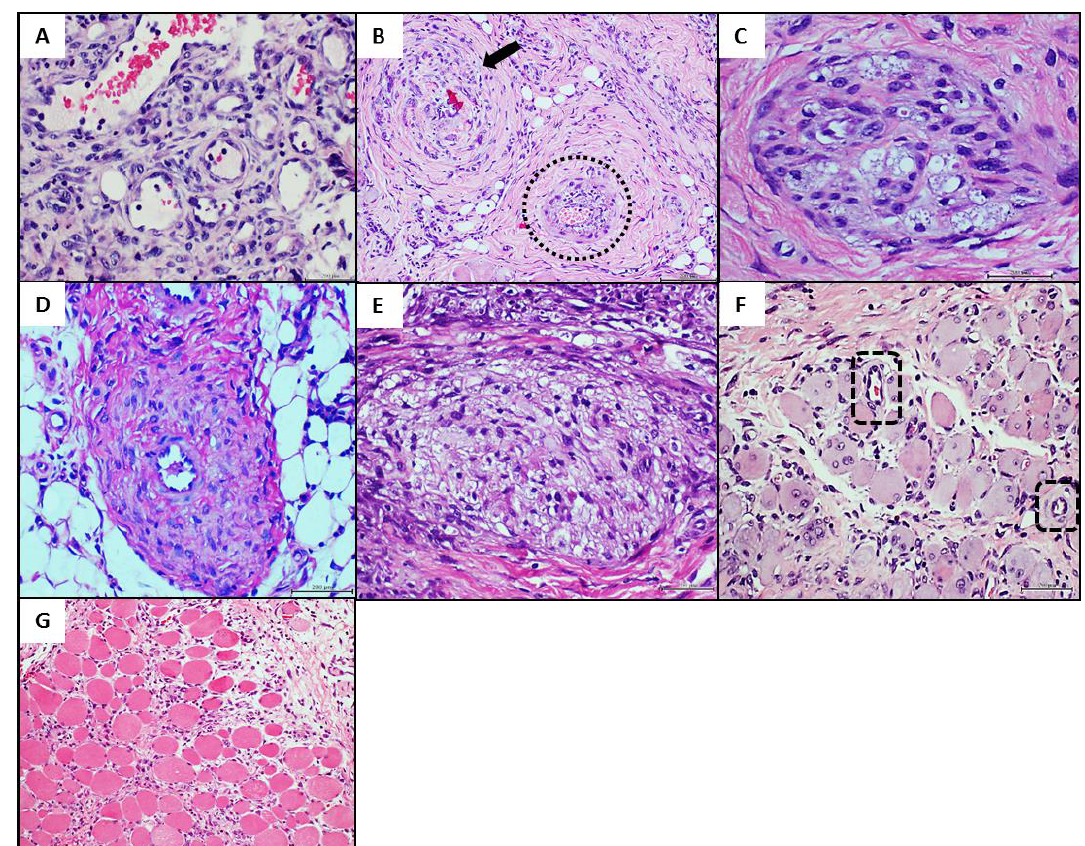
Figure 2. Histological characterization of recipient rats’ granulation tissue by hematoxylin/eosin staining. ( A ): Representative of normal granulation tissue vessels in control rats infiltrated with healthy donor/normal brachial artery CFF. An abundant number of morphologically normal neovessels with patent lumen are shown. Granulation tissue matrix is infiltrated by round cells and other with fibroblastic-like phenotype. Magnification 40×. ( B ): Represents the granulation tissue vascular response to arteriosclerotic material-derived CFF in which a neoformed arteriole exhibit intense wall thickening (arrow), abnormal cellular infiltration and disorganization. There is an exaggerated accumulation of circular and concentric collagen bundles. The lumen is almost completely obliterated. The doted circle shows another arteriole affected by intimal expansion associated to subintimal cellular infiltration. Magnification 20×. ( C ): A node of abnormal and incomplete angiogenesis in rats infiltrated with the arteriosclerotic material-derived CFF is shown, having tunnel-like structures often with scarce or no endothelial cells lining. Other large basophilic nuclei are also evident. There is an external ring of cells with endothelial and fibroblastic-like phenotypes. Magnification 40×. ( D ): A granulation tissue arteriole exhibiting a significant media layer hyperplasia due to collagen accumulation with a notorious hypercellularity. Magnification 40×. ( E ): The image shows the remnant of an arteriole with complete luminal invasion by protruding hypertrophic and fusiform-like cells that appear to emerge from the endothelial side and project into the lumen, eventually forming a trabecular structure. The luminal mesh is infiltrated by round basophilic nuclei-suggestive of lymphocytes and other of fibroblastic aspect (compare to Figure 1F). Magnification 40×. ( F ): The doted squares show the presence of vascular structures with or without endothelial collars, organized within the myofibrillar parenchyma of the panniculus carnosum layer in rats treated with the pathologic donors ’ filtrates. This represents an aberrant angiogenic response of the recipient rats to arteriosclerotic material-derived CFF. Magnification 20×. ( G ): Cross section of the panniculus carnosum layer leading edge, showing the normal integrity of the myofibrils in control rats treated with healthy donor/normal brachial artery CFF. Magnification 20X. For all images, the scale bar represents 200 µm.